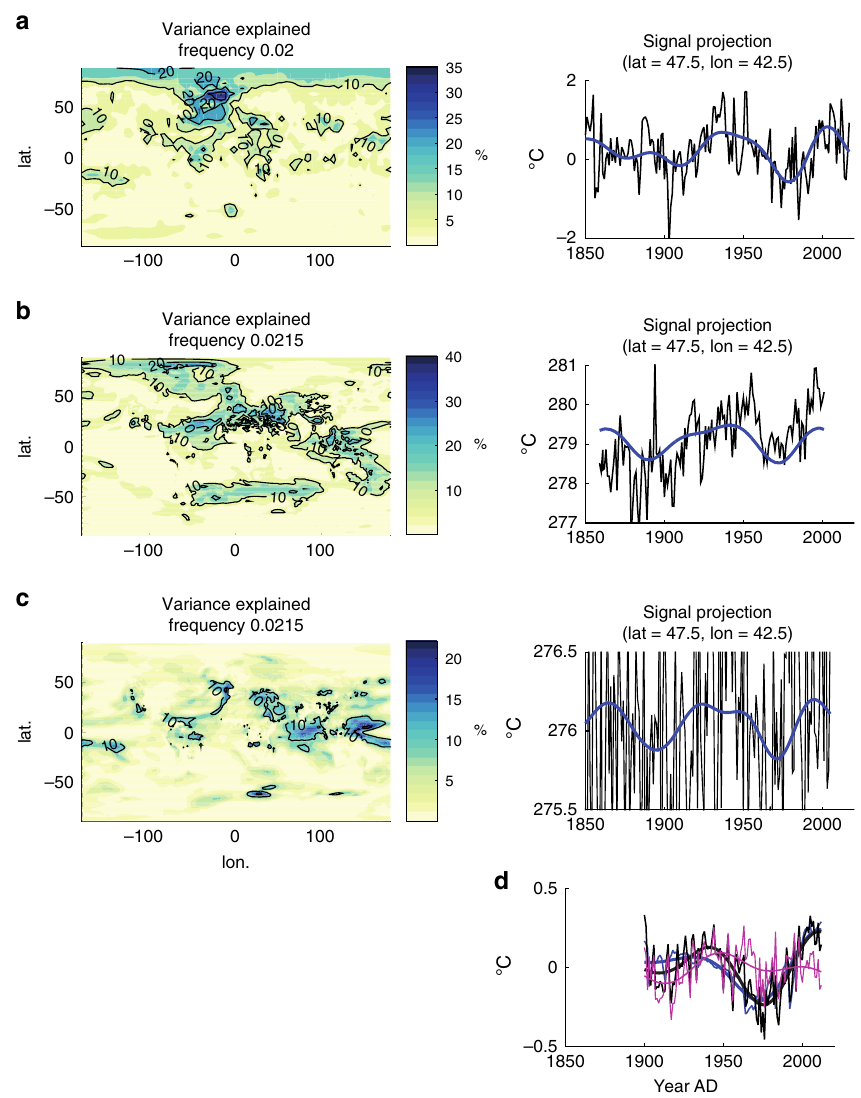
Fig. 3 Spatial pattern of explained variance and time domain signal for AMO. a observations, b HadGEM2-ES model simulation and c MPI-ESM-LR model simulation. Shown for comparison is the analysis by Mann et al. 26 discussed in text. In a – c , the raw temperature time series (black) and reconstructed Atlantic Multidecadal Oscillation (AMO) time-domain signal (blue) are both shown. In d , shown are the linearly detrended historical Northern Hemisphere (NH) mean temperature (black thin), and its 40 year smooth (black thick), the linearly detrended CMIP5 multimodel mean NH mean temperature (blue thin) and its 40 year smooth (blue thick), and an estimate of the true AMO internal series (purple thick) and its 40 year smooth (purple thick) based on removing the estimated forced component (CMIP5 multimodel mean) from the instrumental NH mean temperature. The x -axis on right side panels is year